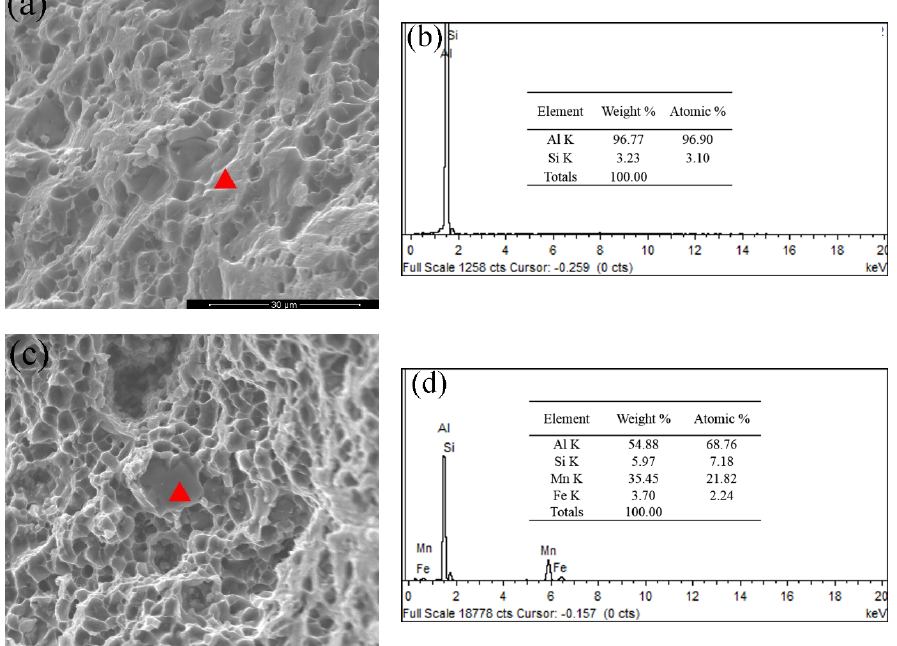
Figure 11. SEM fractography of the T6-treated alloys. ( a ) The fracture surface of α -Al grain, ( b ) EDS analysis results of α -Al grain, ( c ) the fracture surface of α -Fe intermetallic and ( d ) EDS analysis results of α -Fe